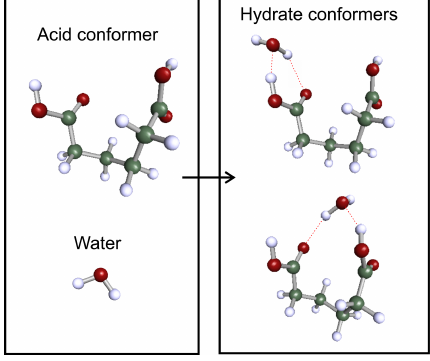
Figure 2. The formation of dicarboxylic acid hydrate conformers. Color coding: green is C, white is H, and red is